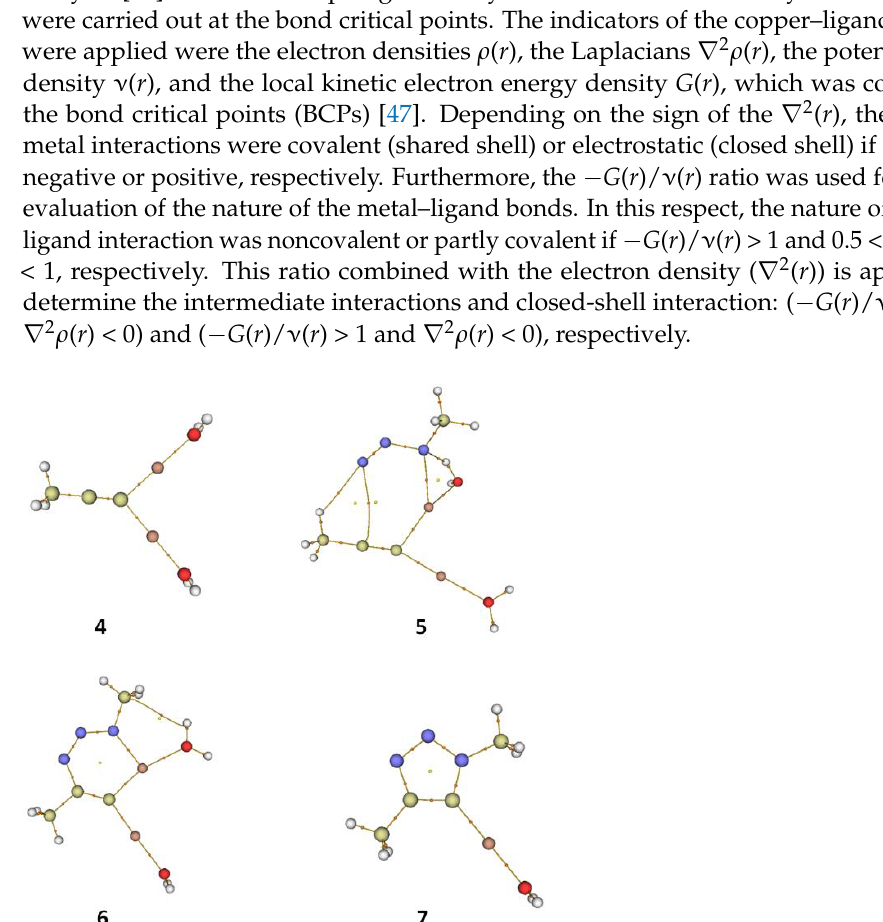
Table 4. NBO analysis for the intermediate complexes in the CuAAC reaction.